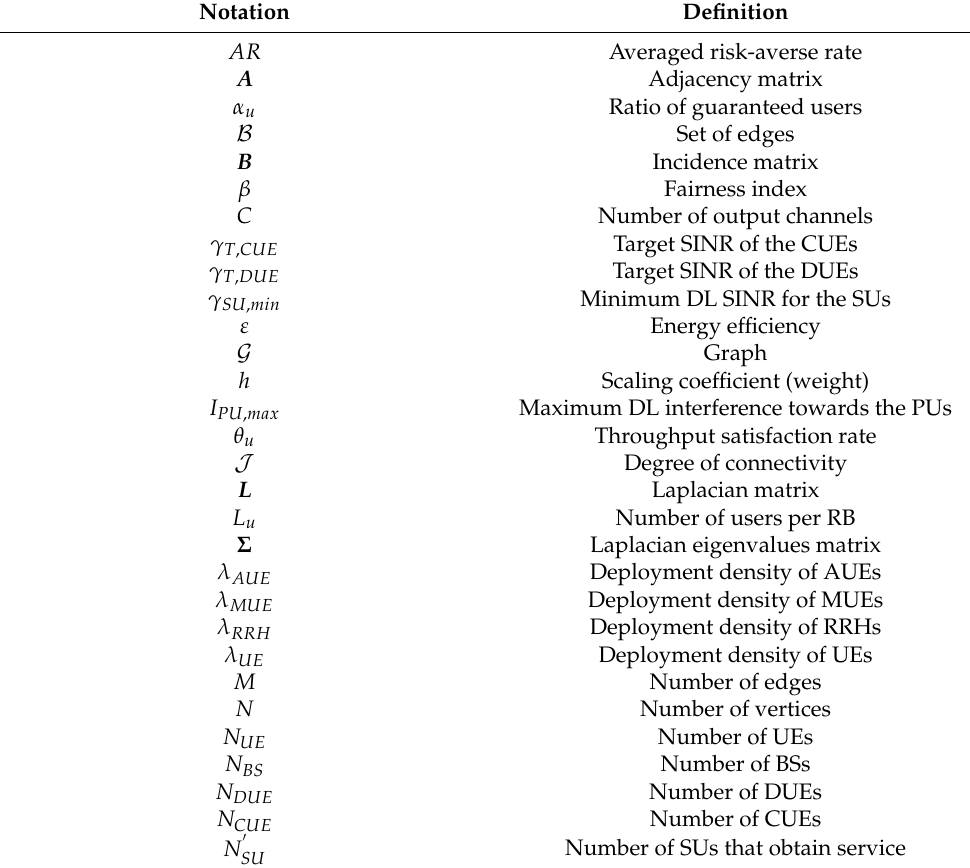
Table 3. Table of